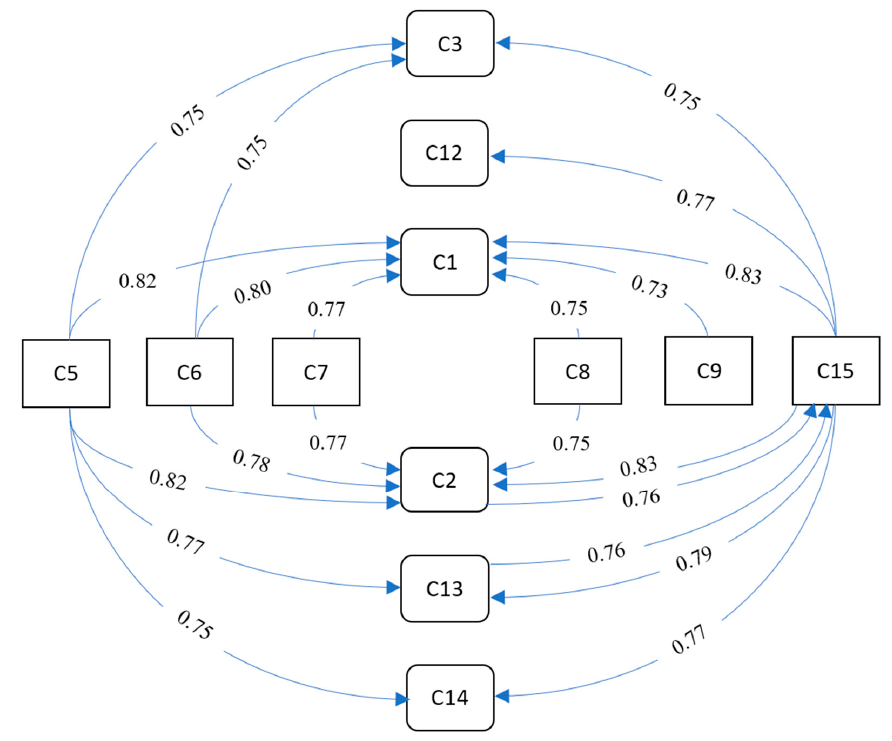
Figure 3. Causal relationship among critical barriers of Industry 4.0 adoption.